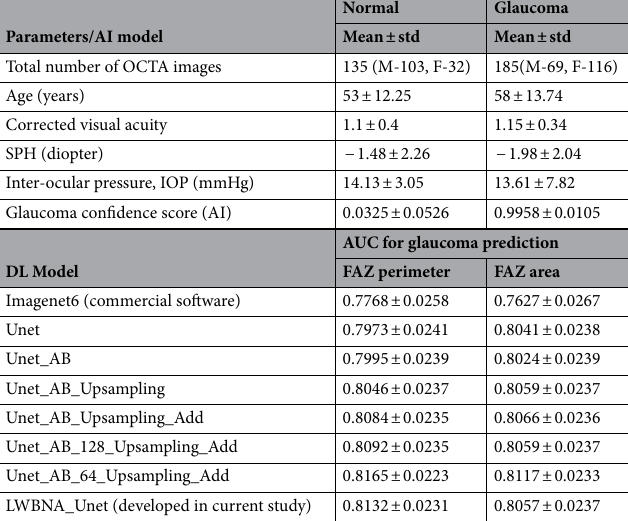
Table 1. Dataset for testing the discrimination ability of glaucomatous eyes from normal using FAZ parameters obtained from DL models. Data exclusion criteria: SPH higher than − 6.0 and + 3.0 diopter; Age: lower than 20 years, M: Male, F: Female, Images: Visually unclear FAZ boundary.